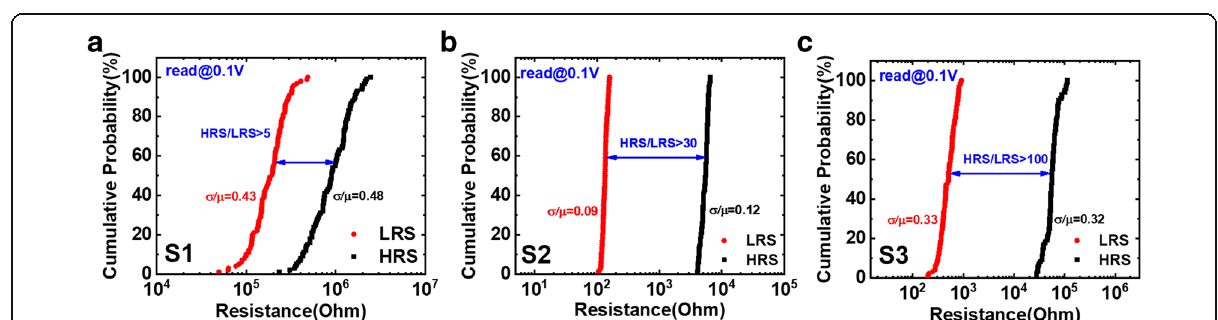
Fig. 6 Cycle-to-cycle variation of R LRS and R HRS for 100 cycles in a S1, b S2, and c S3